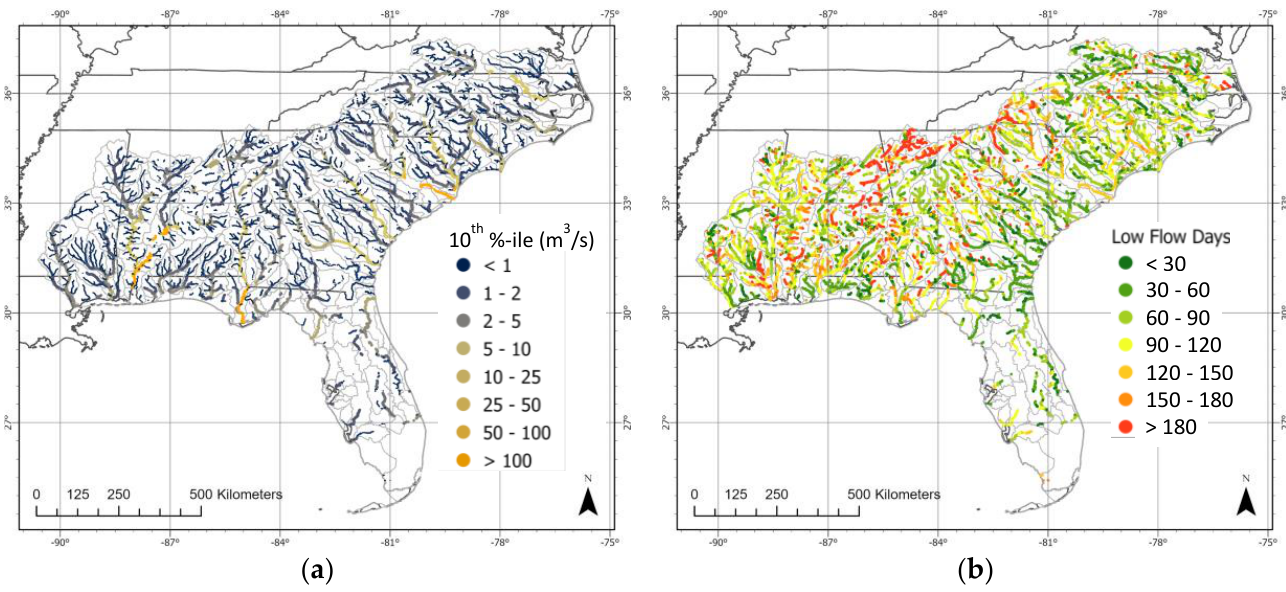
Figure 2. Annual average patterns of: ( a ) 10th percentile threshold (m 3 /s) and; ( b ) low flow frequency (total number of 7Q10 days) over the study region based on NWM retrospective simulations.